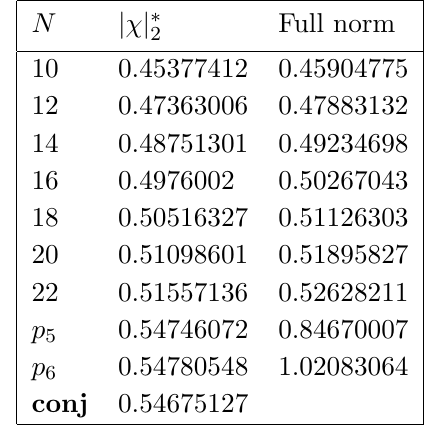
Table 5 . Norm at level 2 in the case of overlap. Shown is projection onto the four relevant states. In the right column is the full norm for comparison. The presence of parasitic couplings in the latter case leads to a di(cid:11)erent result, which moreover cannot be reliably extrapolated. The conventions used for the extrapolations p 5 and p 6 are the same as in table